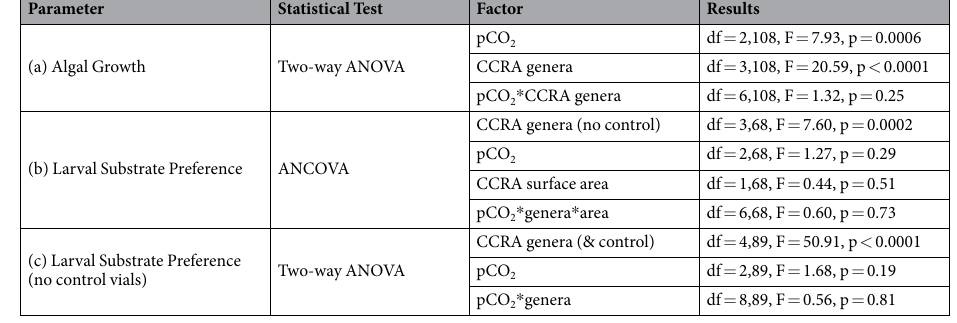
Table 2. Statistical Results. (a) Effects of pre-condition pCO 2 treatments on algal growth, (b) larval substrate preference (no control vials included) and accounting for algal area in vials, (c) larval settlement preference including control vials, and (d) larval substrate preference (no control vials included).